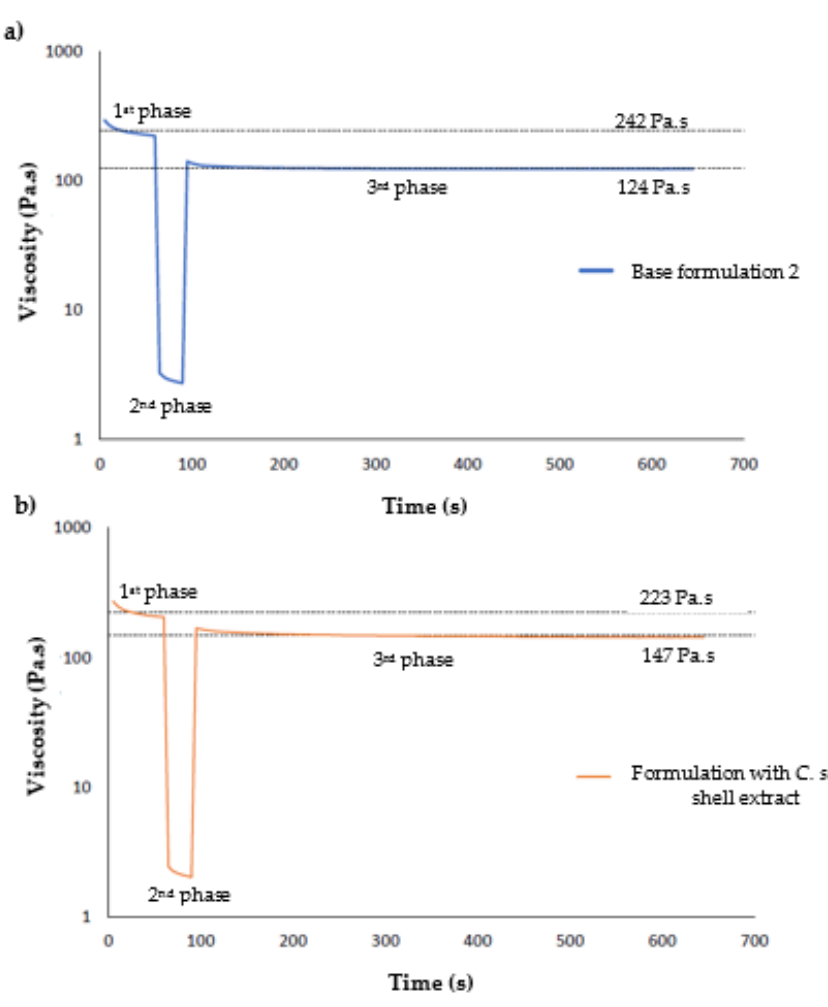
Figure 5. Graphic that represents the variation of the viscosity (Pa.s) with time of deformation (s) for Base Formulation 2 ( a ) and O/W formulation containing C. sativa shells extract ( b ), at a shear rate from 0.1 to 100 s −1 and returning to 0.1 s −1 (mean ± standard deviation, n = 3).